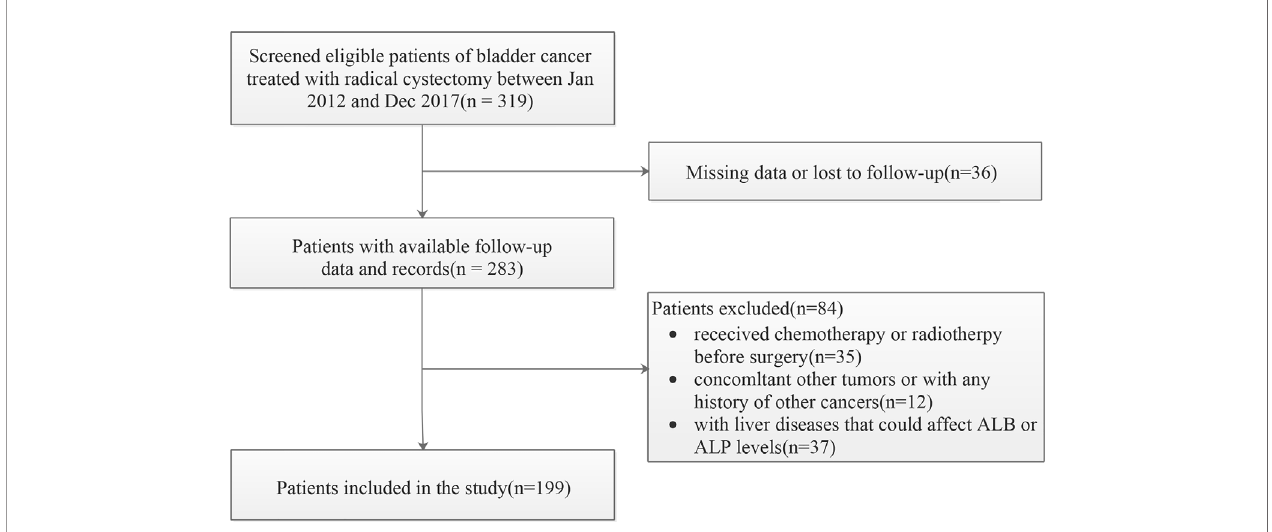
FIGURE 1 | The patient selection fl